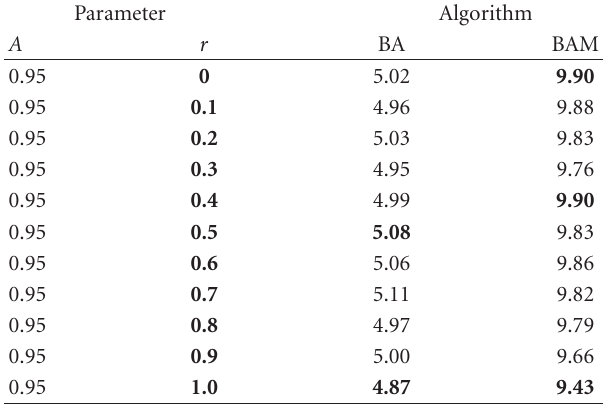
Table 17: Average CPU time on UCAV path planning problem on di ff erent r . The numbers shown are the minimum average CPU time (sec) consumed by BA and BAM